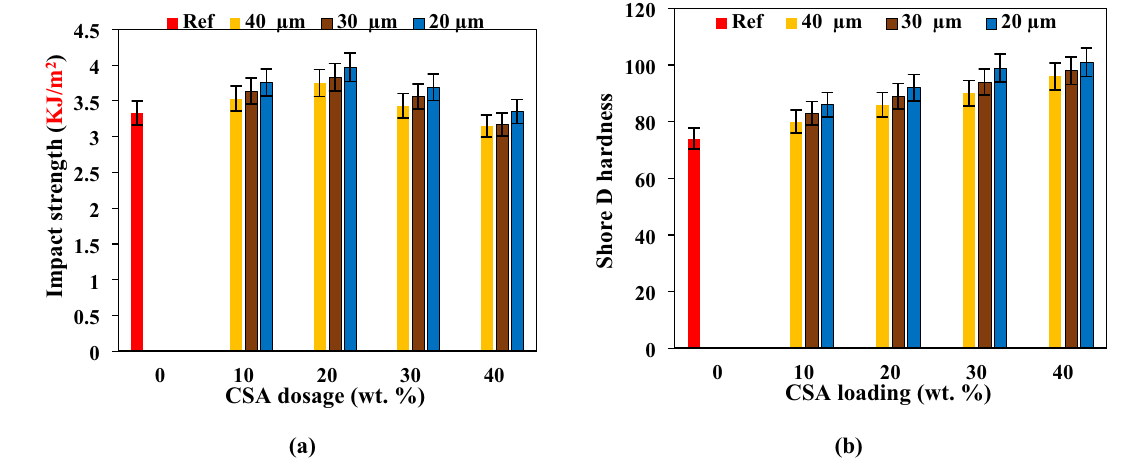
Figure 4. Influence of CSA proportion and size on ( a ) impact strength ( b ) shore D